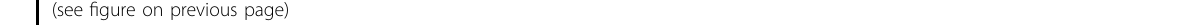
Fig. 1 Distinct fi broblast subpopulations in human HBV-related HCC. a Schematic diagram of scRNA-seq analysis work fl ow. HCC and adjacent tissues were dissociated into single cells, and sequenced using 10× Genomics platform. b UMAP plots for the different clusters ’ identi fi cation of single cells in human HCC tumor. c Violin plots showing the speci fi c cell marker for different cell types in human HCC tissues. d α -SMA expression in human HCC and normal tissues by IHC experiments. e UMAP plots show 5 different CAF clusters in human HCC tumors. f Heatmap showing the top DEGs (Wilcoxon test) in each CAF subtypes. g UMAP plots show marker genes in different CAF clusters. h KEGG analysis in different CAF subtypes. i GO analysis in different CAF subtypes. j UMAP plots for CAF subtypes in HBV related HCC tumors. k UMAP plots for CAF subtypes in non-HBV related HCC tumors. l The comparison of CAF subtypes between HBV-HCC and non-HBV HCC tumors. m Multiplex immuno fl uorescence staining showed major CAF clusters existed in human HCC